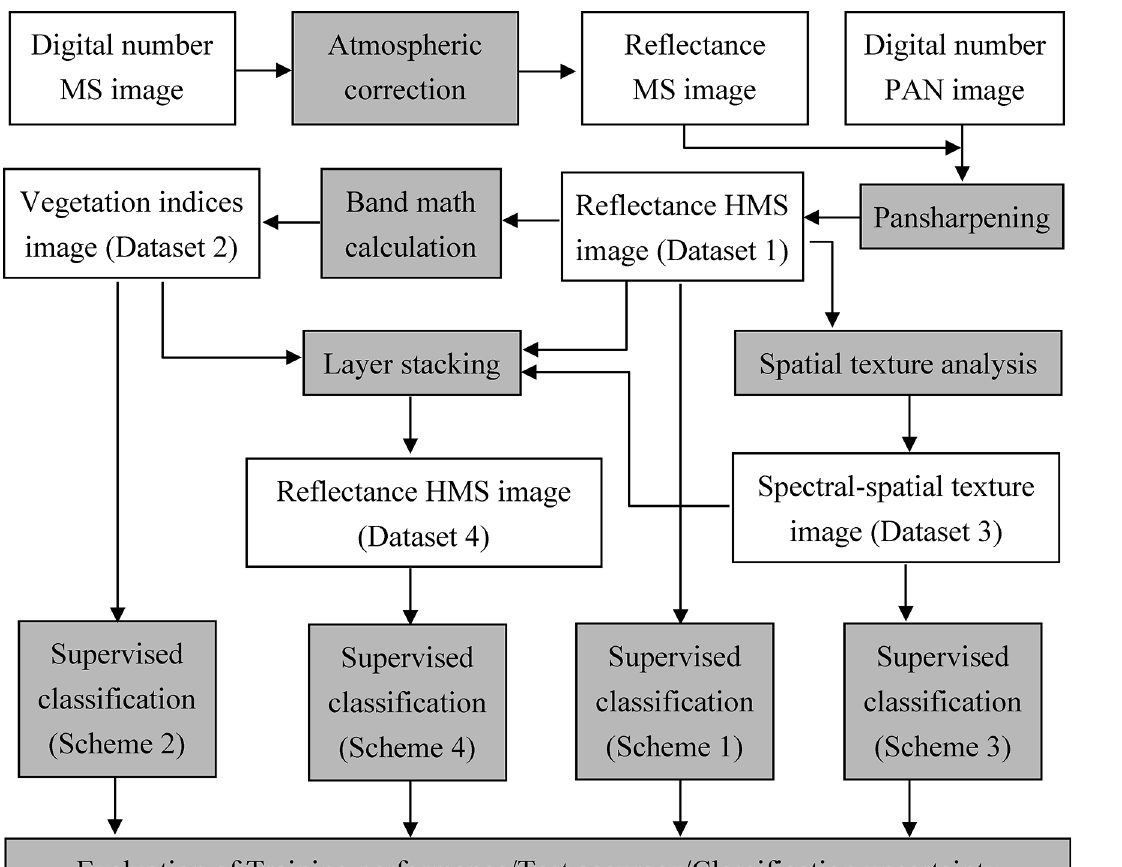
Fig 3. Flowchart of image processing and analyses used in this study.